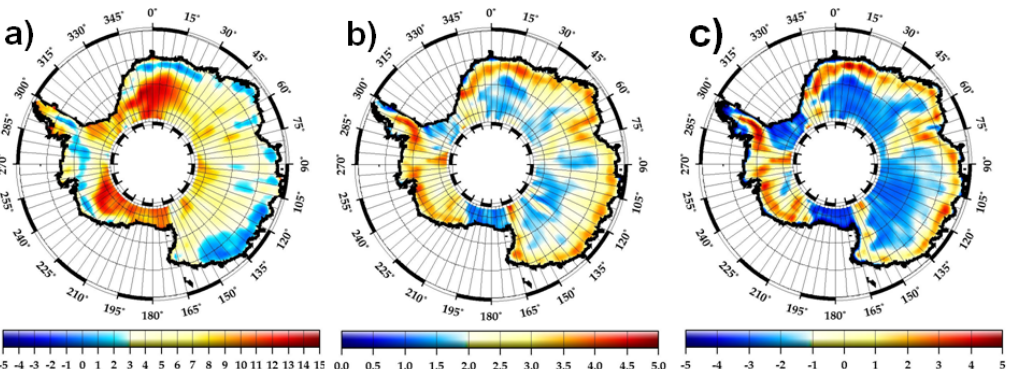
Figure 4. Mean altimetric waveform parameters mapped over Antarctica in Ku-band from 2003 to 2007. (a) The backscattering coefficient expressed in dB, (b) the leading edge width expressed in meters, (c) the trailing edge slope expressed in 10 6 s − 1